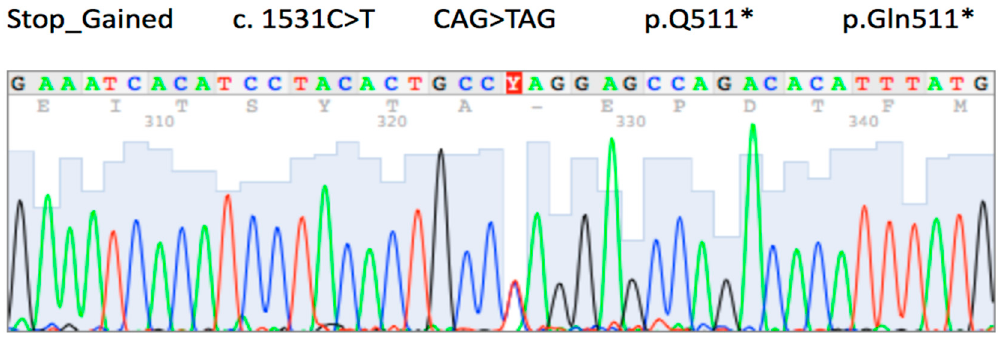
Figure 1. Partial Electropherogram showing the C > T change in the proband identified with the c.1531C > T pathogenic mutation. The red Y shows the place in the sequence where a double peak occurs (heterozygous Genotype). * Incomplete protein.